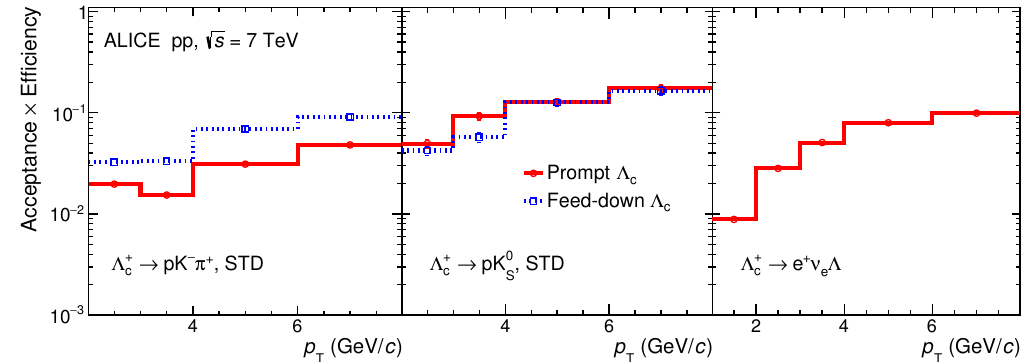
p Figure 6 . Product of acceptance and e(cid:14)ciency for (cid:3) c in pp collisions at s = 7 TeV, as a function of p T . From left to right: (cid:3) + ! pK (cid:0) (cid:25) + , (cid:3) + ! pK 0 , and (cid:3) + ! e + (cid:23) e (cid:3). For hadronic decays the c c c S solid lines correspond to the prompt (cid:3) c , while the dotted lines represent ( A (cid:2) (cid:15) ) for (cid:3) c baryons originating from beauty-hadron decays. The e(cid:14)ciency for semi-leptonic decays (same for both prompt and non-prompt (cid:3) c ) is represented with one solid line. The statistical uncertainties are smaller than the marker